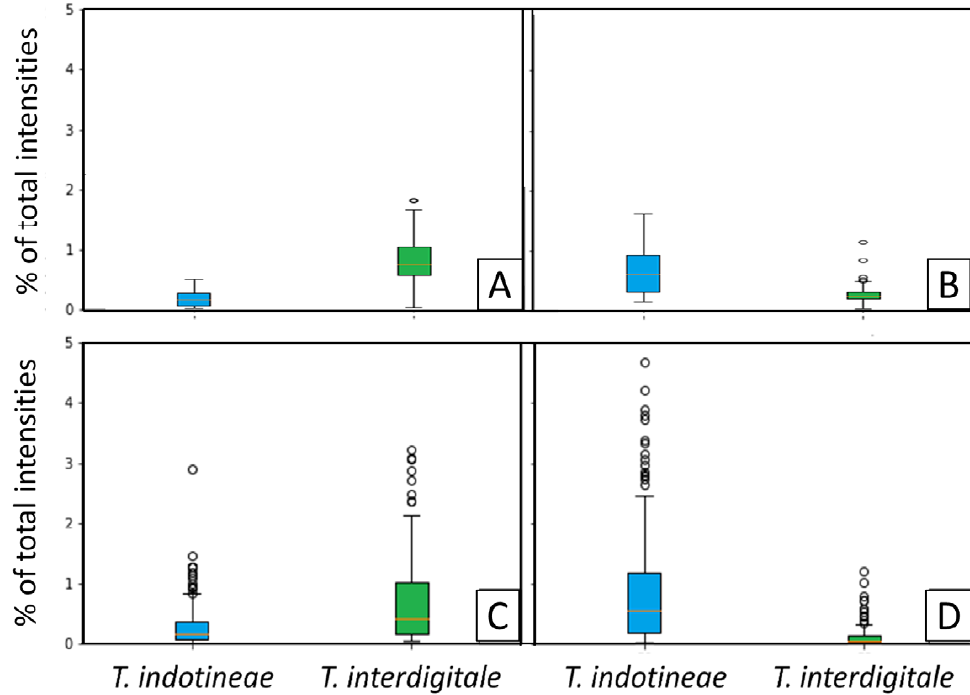
Figure 2. Comparison of the aligned spectra obtained at the various stages of growth for T. indotineae isolates on both IDFP ( A ) and SDA-CG agar ( B ). To visualize increases or decreases in the intensities of some peaks, a zoomed-in view of two portions of the spectra (5000–16750 Da; 10,000–11,750 Da) is shown. The highest peaks in intensity are represented by the brightest colors.